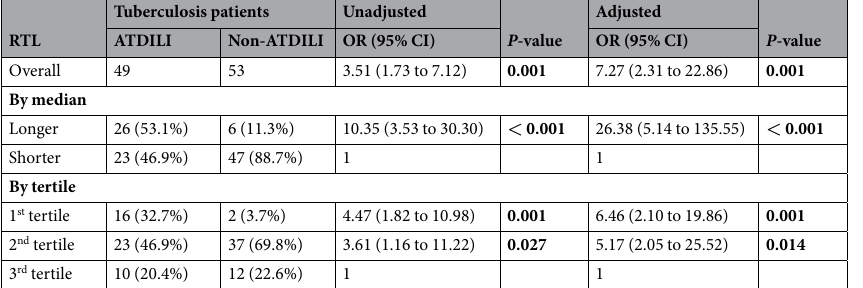
Table 2. Associations between blood leukocyte RTL and risk of ATDILI. Adjusted for age, gender, BMI, drinking status, and smoking status. Abbreviations: ATDILI, anti-tuberculosis drug-induced liver injury; BMI, body mass index; CI, confident interval; OR, odds ratio; RTL, relative telomere